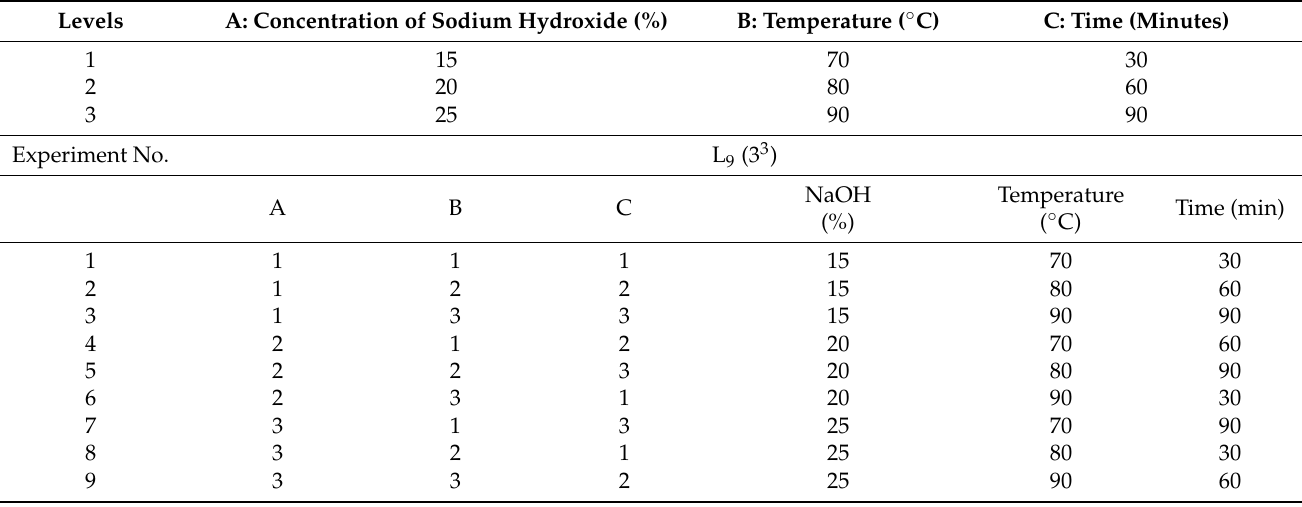
Table 1. Factors and their levels assigned to different columns and the orthogonal array of an L 9 (3 3 ) design for optimizing the alkaline extraction conditions by the Taguchi